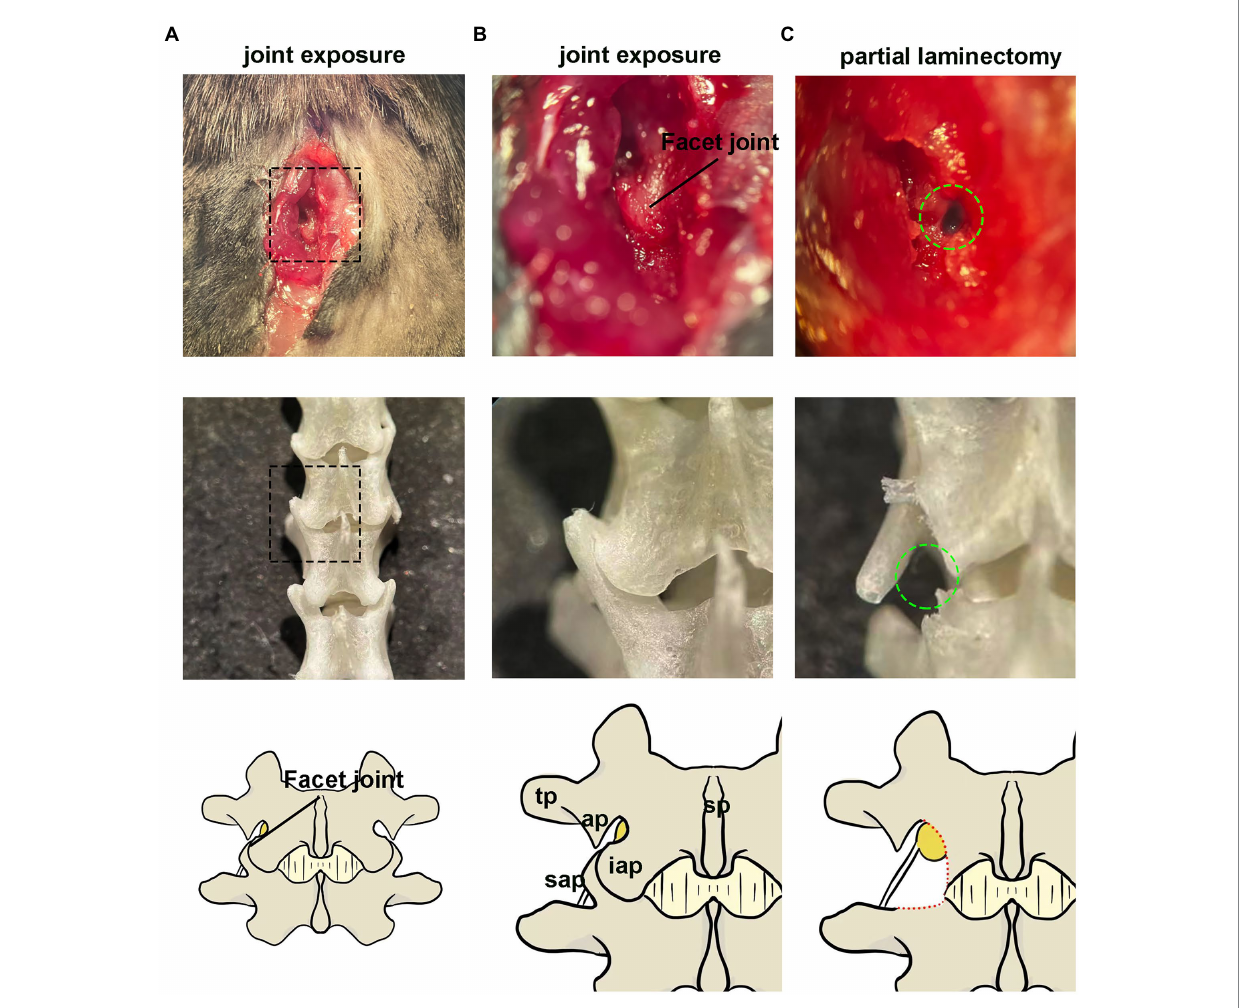
FIGURE 2 Paravertebral surgical exposure for ganglionic injection. Images show as the operative field (top panel), cleaned vertebral bones (middle panel), and reference diagram (bottom panel). (A,B) Preliminary soft tissue dissection at the level of the L4–L5 facet joint shows the spinous processes (sp), inferior articular process(iap), and superior articular processes (sap), as well as the laminar bone (lam) and accessory process(ap) on L4. The dorsal root ganglia are covered by a facet joint. (C) Removal of the facet joint bone above the foramen reveals the distal dorsal ganglion, which is much larger in diameter and located under the arm of L4 accessory